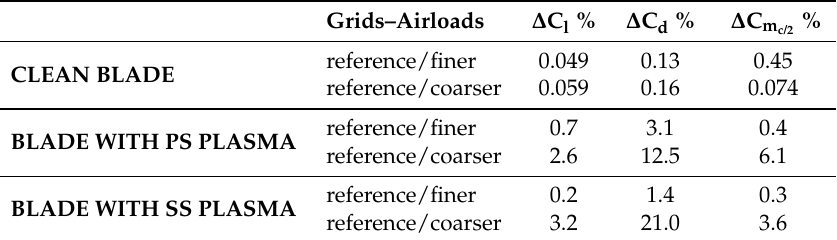
Table 2. Percent difference between the aerodynamic loads computed on the reference grid and the counterparts achieved on the finer and on the coarser mesh; clean cascade, with PS the actuated cascade and SS the actuated cascade; Re ∼ 350,000; α = 8